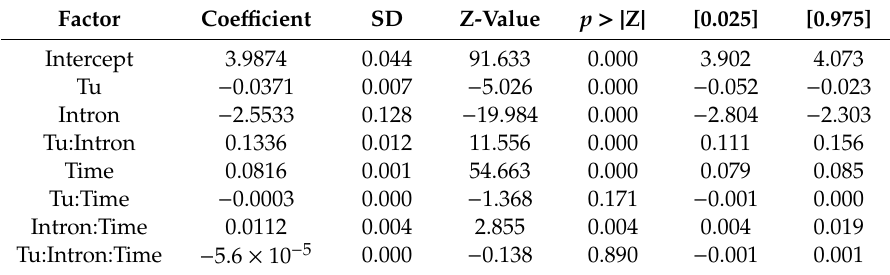
Table 5. Results of Poisson GEE Regression with Autoregressive Covariance Structure 1